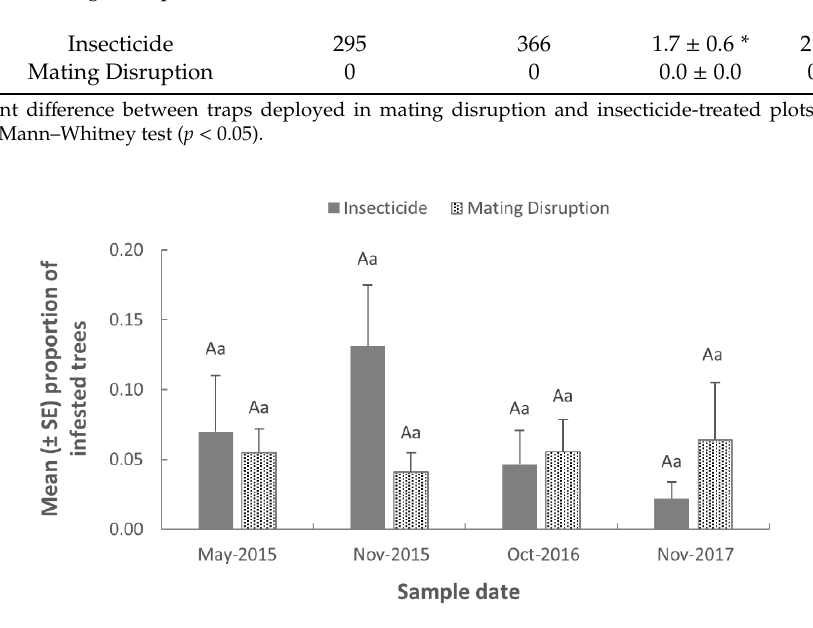
Figure 2. Mean ( ± SE) proportion of peach trees infested with S. exitiosa larvae in plots treated with insecticide or mating disruption. Uppercase letters indicate comparisons between treatments within each sample date ( p > 0.05). Lowercase letters indicate comparisons among sample dates within each treatment ( p > 0.05).